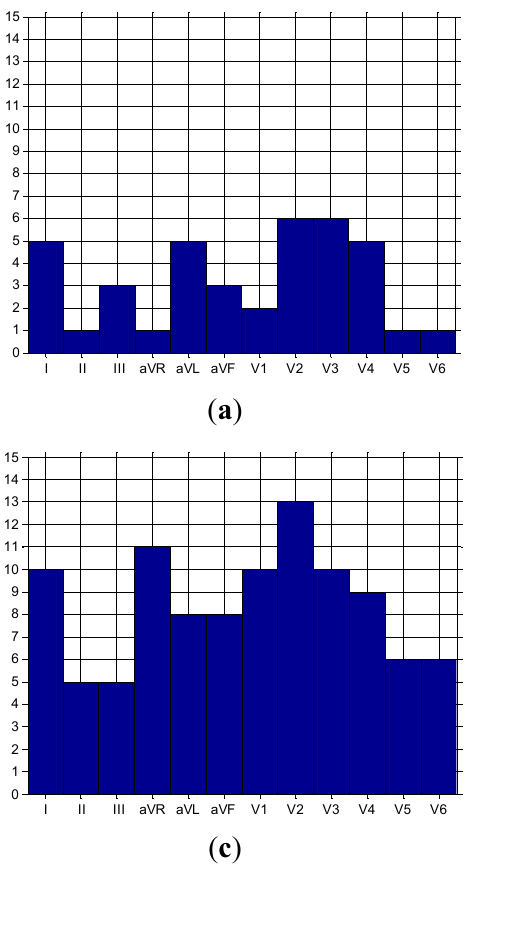
Figure 6. Bar plots of the lead quality ( a ) Q0, ( b ) Q1, ( c ) Q2 and ( d ) Q3 for all leads from a 12-lead